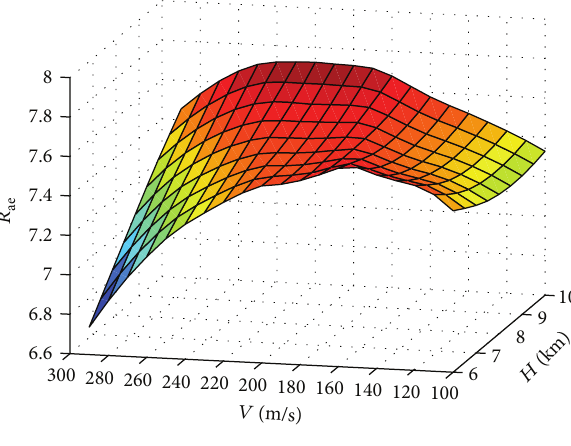
Figure 9: 𝑅 ae with different initial